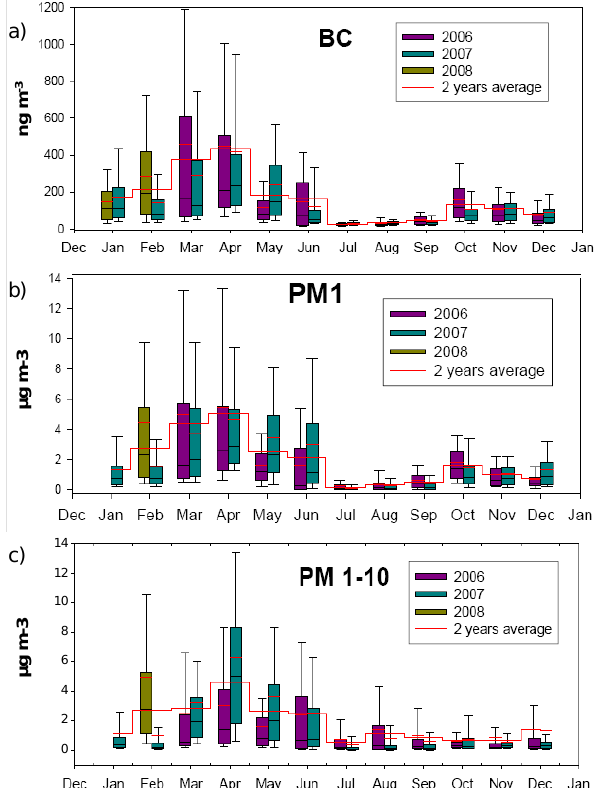
Fig. 2. Monthly averages (black line within the boxes), medians (red line within the boxes) and percentiles (10-25-75-90, boxes and whiskers) of 30-min PM 1 (a) , PM 1 − 10 (b) and BC (c) at NCO- P. The continuous red lines represent the 2 year averaged monthly behaviours.